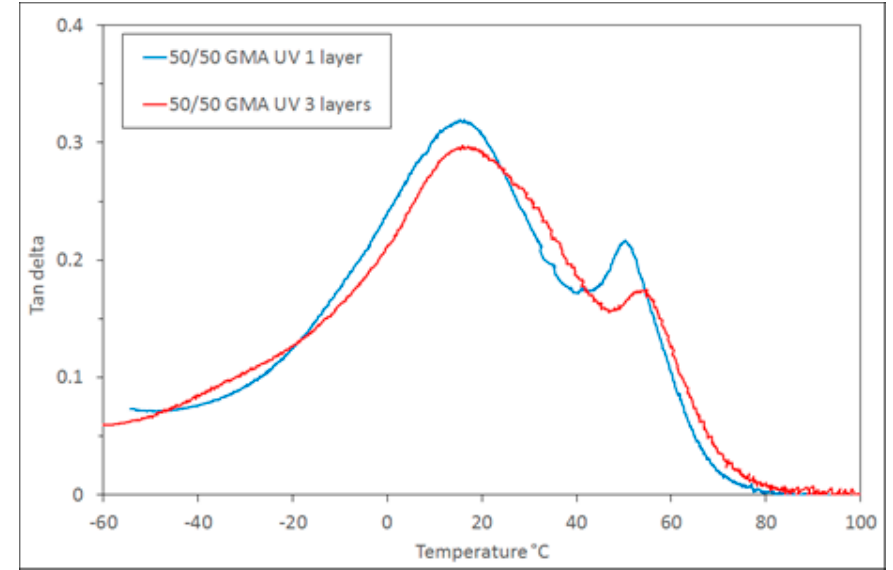
Figure 9. DMTA tan δ of the 1 layer and 3 layer 50/50 GMA samples.